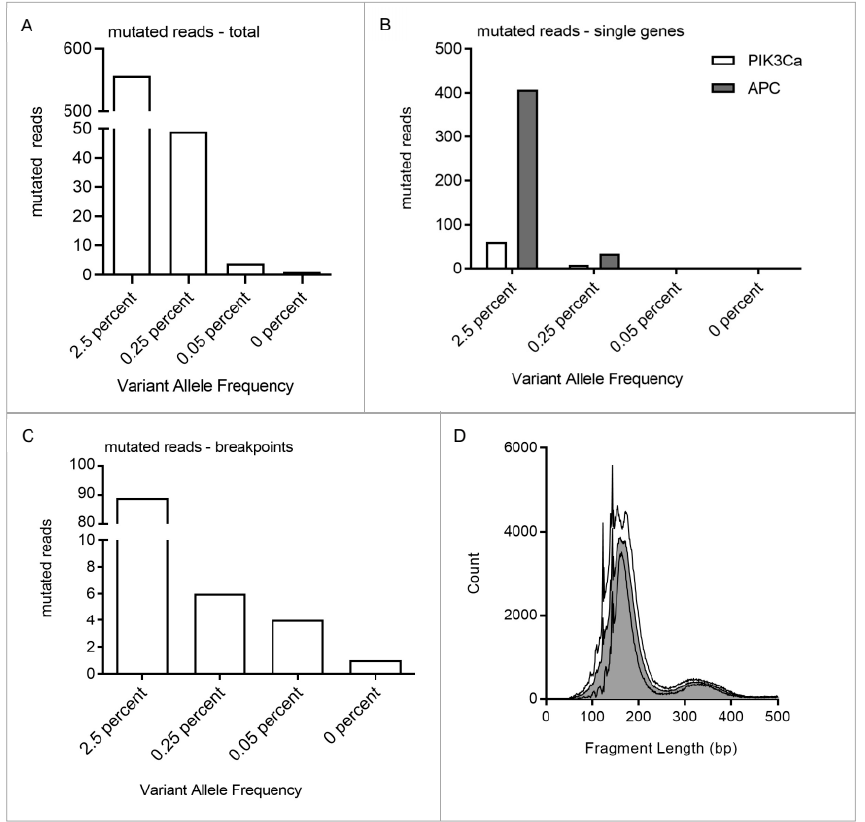
Figure 3. Dilution series of FUJI cell line DNA. DNA was fragmented and mixed with 10 ng cfDNA from a healthy donor to a VAF of 2.5%, 0.25%, 0.05% and 0%. Mutational profiling of the cell line and donor cfDNA revealed one breakpoint and mutations in PIK3CA and APC . A total of five mutations could be tracked, one breakpoint and four SNVs. ( A ). The lower limit of detection of the subtype-specific panel was determined by quantifying the mutated reads within each sample. Fuji cell line DNA was detectable even at a VAF of 0.05%. Respective values were: VAF 2.5%: 557 reads, VAF 0.25%: 49 reads, VAF 0.05%: 4 reads and VAF 0%: 1 read. ( B ). Mutated reads were further divided into breakpoint reads and reads with point mutations. Point mutations could be detected in PIK3CA and APC in 2.5% and 0.25% VAF samples. ( C ). Breakpoints could even be detected within the samples with the lowest VAF of 0.05%. One false positive event was identified in the 0% VAF sample. ( D ). Depicted are the fragment length distributions of each sample. Median fragment length is 182 bp.